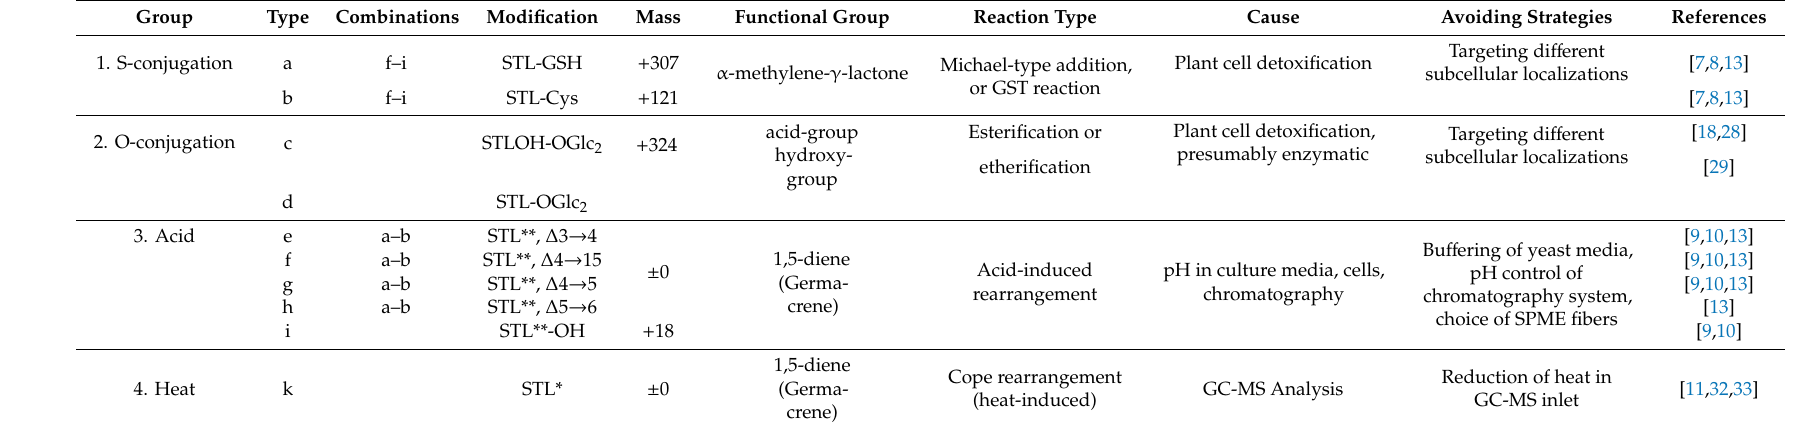
Table 1. Classification and avoidance of unspecific